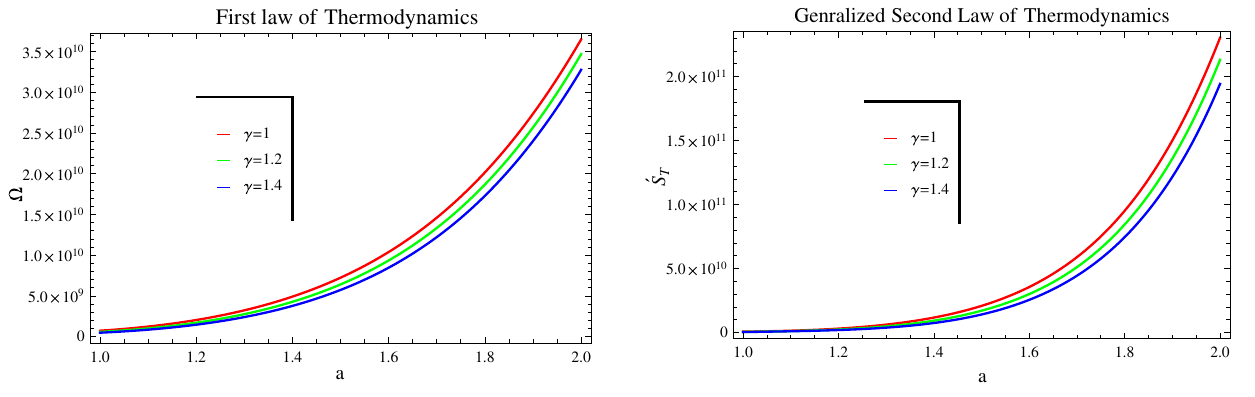
Fig. 8 Plot of ´ S T versus a for power law corrected entropy using k = 1 , λ = − 1 , α = − 1 , L p = 1 , r c = 1